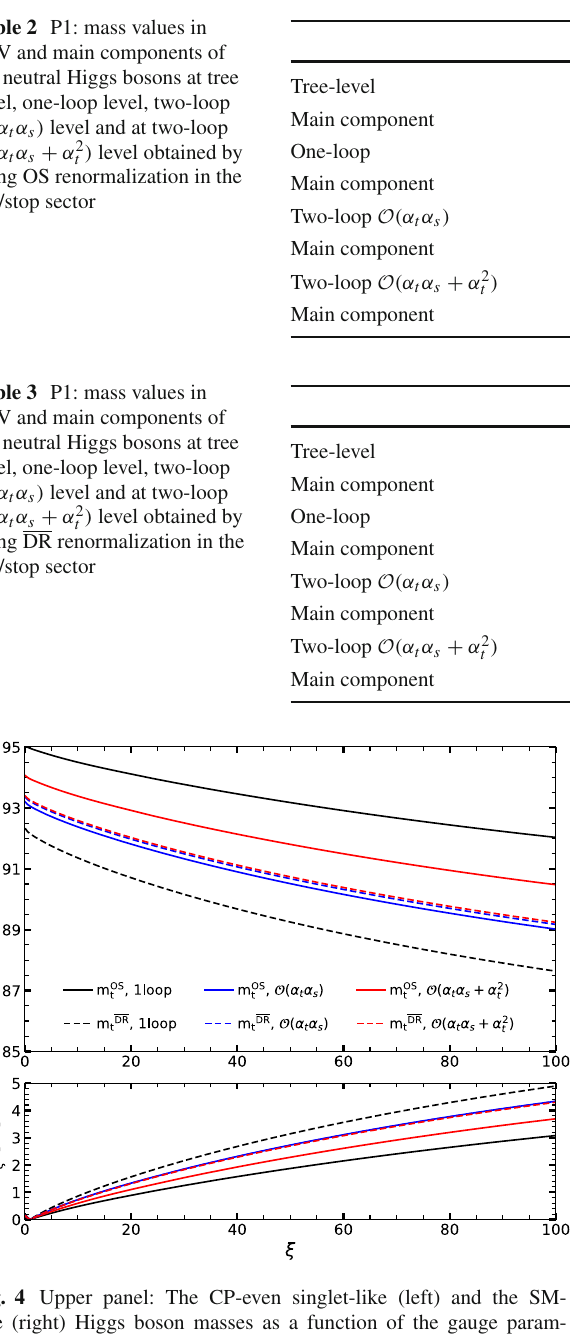
Fig. 4 Upper panel: The CP-even singlet-like (left) and the SM- like (right) Higgs boson masses as a function of the gauge param- eter ξ at the one-loop (black), two-loop O (α t α s ) (blue), two-loop α + α 2 ) (red) level in the OS (solid lines) and the DR (dashed O (α t s t lines) scheme of the top/stop sector. Lower panel: Absolute value of